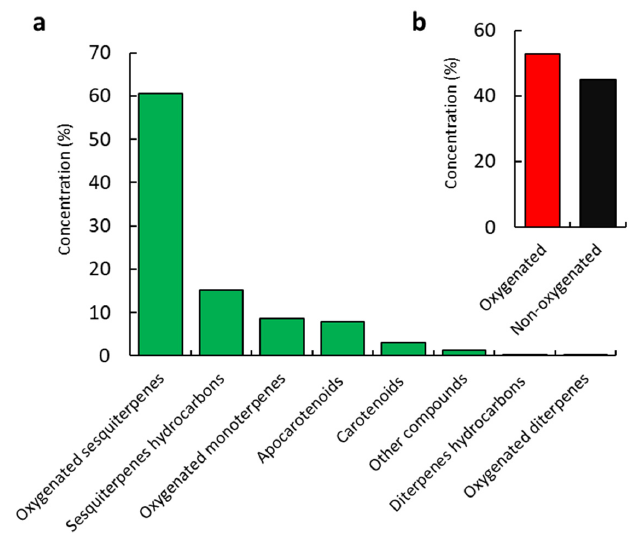
Figure 2. Concentrations of various identified classes of the chemical compounds of the Cleome amblyocarpa EO ( a ) and the percentage of oxygenated and non-oxygenated compounds ( b ). Sesquiterpenes were assigned as the main components involving the oxygenated compounds as majors (60.62%) in addition to a relative concentration of 15.15% of sesquit- erpene hydrocarbons. Out of the 16 identified oxygenated sesquiterpenes, caryophyllene oxide (36.01%), alloaromadendrene epoxide (6.17%), isoshyobunone (4.52%), and shy- obunol (4.19%) represented the major compounds, whereas β -cubebene (0.13%) was the minor compound. Caryophyllene oxide is a common major compound in several EOs de- rived from plants such as Cullen plicata [34], Schinus polygamus [35], Curcuma sahuynhensis [36]. Caryophyllene oxide was documented as a minor compound in the EO of Iranian C. amblyocarpa [27], and totally absent from the EO of C. amblyocarpa collected from the United Arab Emirates [26], Tunisia [37], and Saudi Arabia [28]. On the other hand, trans - caryophyllene (3.45%), and α -muurolene (2.30%) were found to be the main sesquiterpene hydrocarbons, whereas silphiperfol-5,7(14)-diene (0.13%) was determined as a minor component. trans -caryophyllene has been reported in trace amounts of the EO of the Ira- nian ecospecies of C. amblyocarpa [27], whereas it is completely absent from the EO of Saudi [28], Emirati [26], and Tunisian [37] ecospecies. The oxygenated monoterpenes were represented by 8.72%, which contained seven compounds, with myrtenyl acetate (5.73%) and borneol (1.12%) as major compounds. These two compounds are totally absent from the other ecospecies of C. amblyocarpa [26– 28,37]. On the other hand, low diterpene contents were determined and represented by two compounds, geranyl- α -terpinene (0.22%) and phytol (0.17%). However, diterpenes were absent from other ecospecies of C. amblyocarpa . In other species of Cleome genus, phytol was reported in a high concentration such as C. monophylla [23], C. serrata [24], and C. serrata [38]. Carotenoid-derived compounds were determined in a concentration of 3.03%, that represented only two compounds, dihydroedulan II (1.64%) and theaspirane A (1.39%). Only one apocarotenoid-derived compound, hexahydrofarnesyl acetone, was identified with a high relative concentration (7.92%), whereas it was completely absent from the other reported ecospecies of C. amblyocarpa [26–28,37]. Hexahydrofarnesyl acetone is a widely distributed major compound in the EOs of several plants such as Bassia muricata [10], Heliotropium curassavicum [33], Hildegardia barteri [39], Trianthema portulacastrum [40].